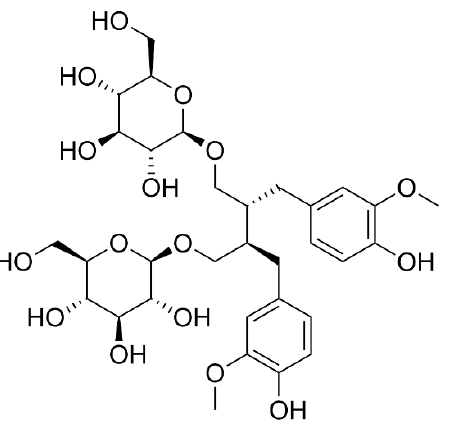
Figure 1. Chemical structure of secoisolariciresinol diglucoside (SDG).